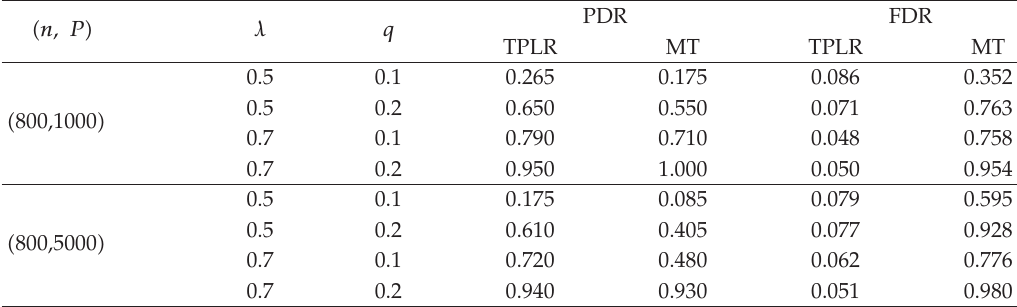
Table 3: The simulated average PDR and FDR under Model 2: multiplicative e ff ects within loci but not between